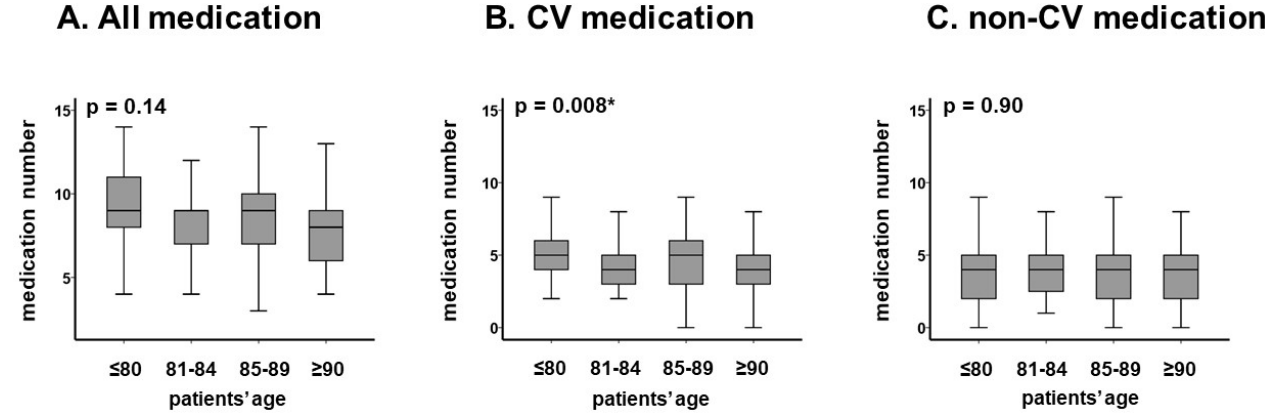
Figure 2. Distribution of median medication number in each age category: all medication ( A ), CV medication ( B ), and non-CV medication ( C ). The numbers of medications were not significantly stratified by age. The numbers of CV medications decreased as incremental age. The number of non- CV medications remained unchanged with incremental age. CV, cardiovascular. Median medication numbers were compared among each group using Wilcoxon signed-rank test. * p < 0.05.